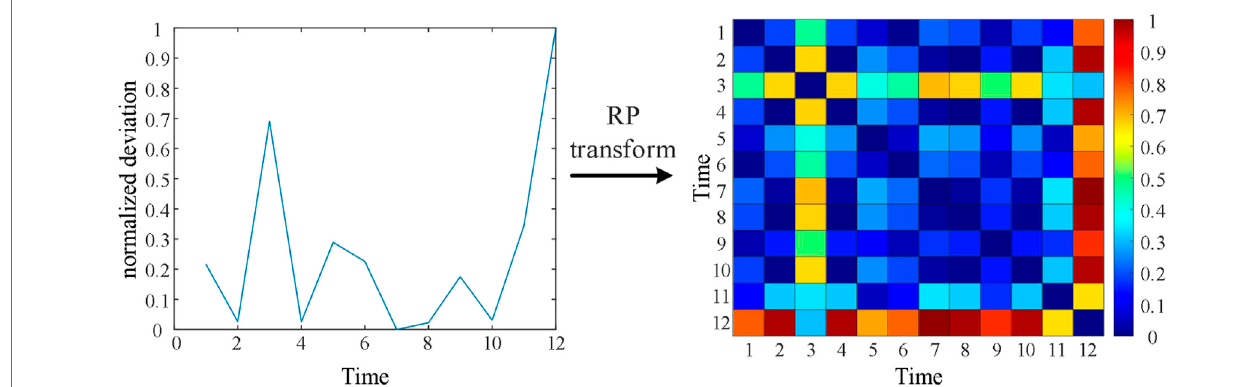
FIGURE 1 | RP encoding of deviation vectors.